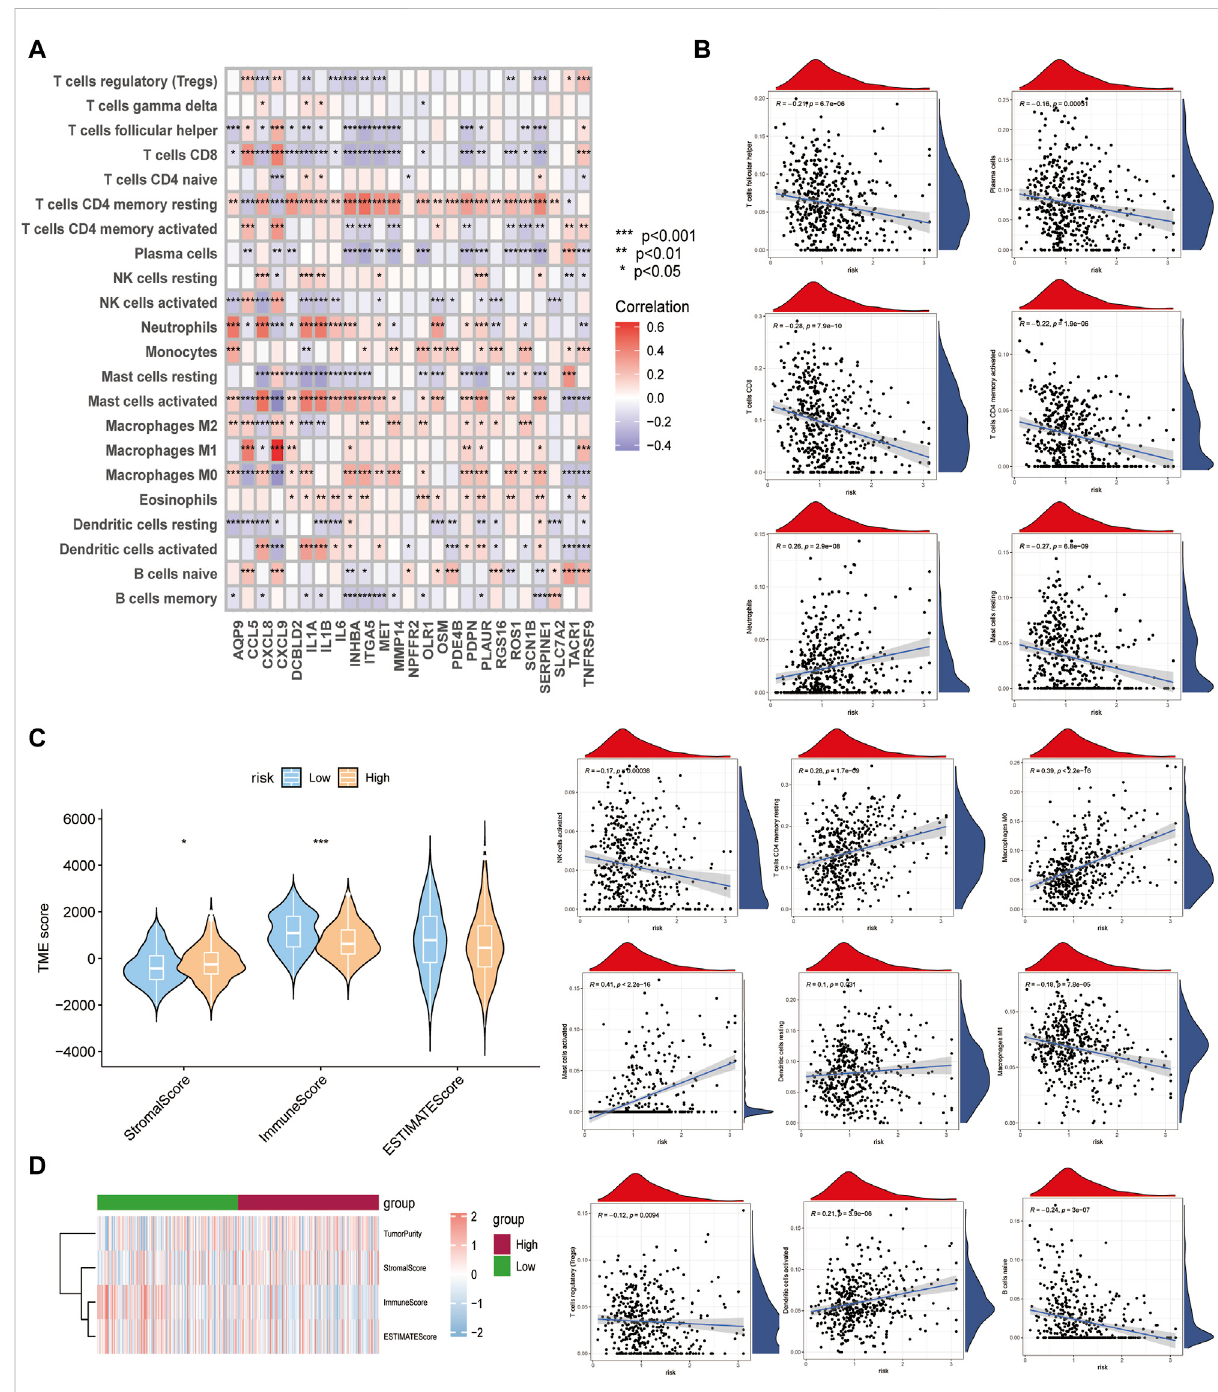
FIGURE 7 Differencesinimmunefunctionbetweenhigh-andlow-risksubgroups. (A) Relationshipbetweencrucialclustergenesandimmunein fi ltration. (B) Relationship between various types of immune cells and risk scores. (C,D) Comparison of Stromal, Immune, Estimate scores between high- and low-risk